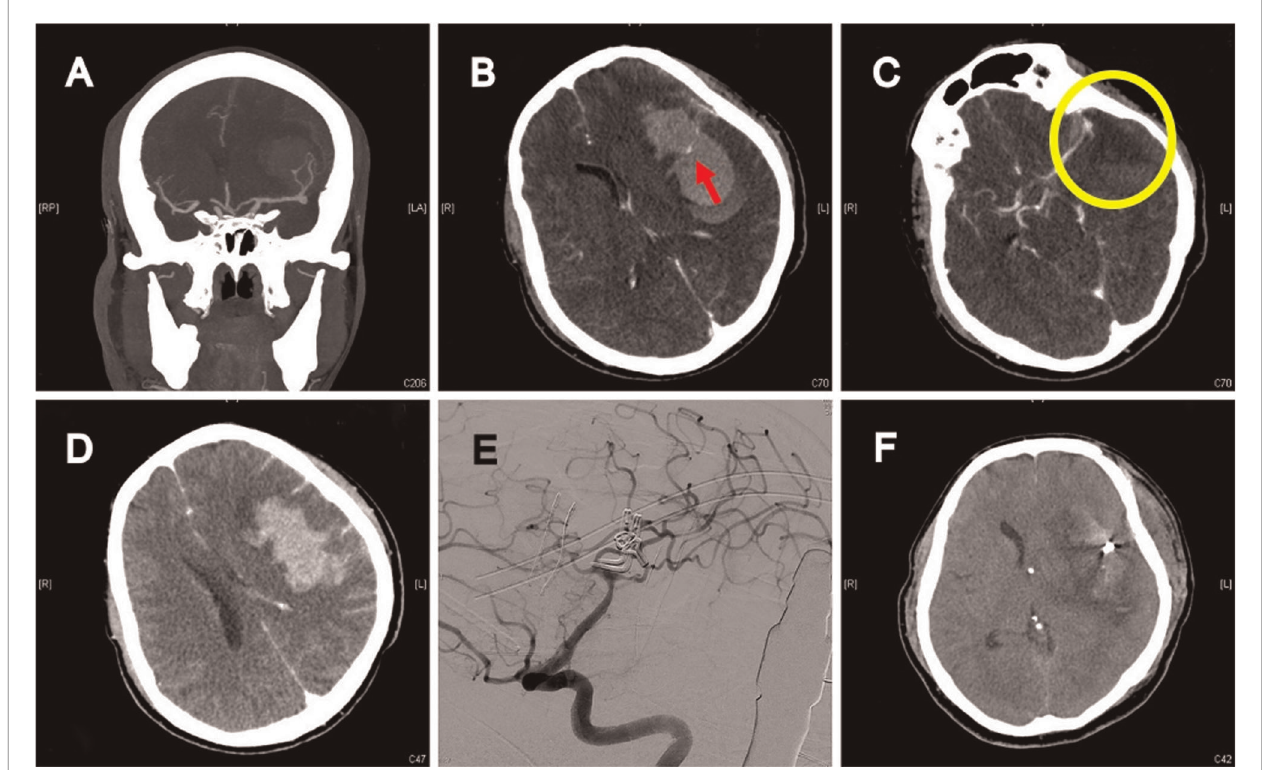
FIGURE 3 | 41-year-old female with high-grade aSAH caused by ruptured left MCA aneurysm. ( A ) Preoperative brain CTA depicted severe aSAH, ICH, and two MCA aneurysms. ( B ) Intra-hematoma spot sign (red arrow). ( C ) Perisylvian low density (yellow circle). ( D ) Distal hematoma. ( E ) 5 days after craniotomy to remove hematoma and clip two aneurysms; post-operative angiography revealed complete obliteration of aneurysms, well preservation of all MCA branches, and no vasospasm. ( F ) Delayed progressive mass effect with midline